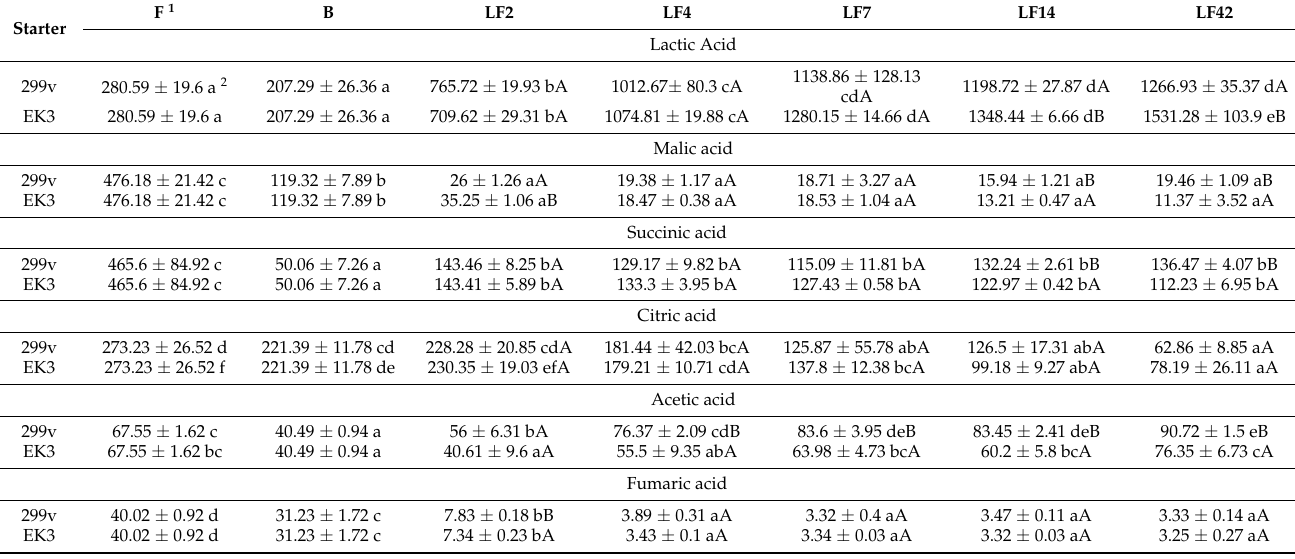
Table 5. Organic acid content in mushrooms (mg/100 g).